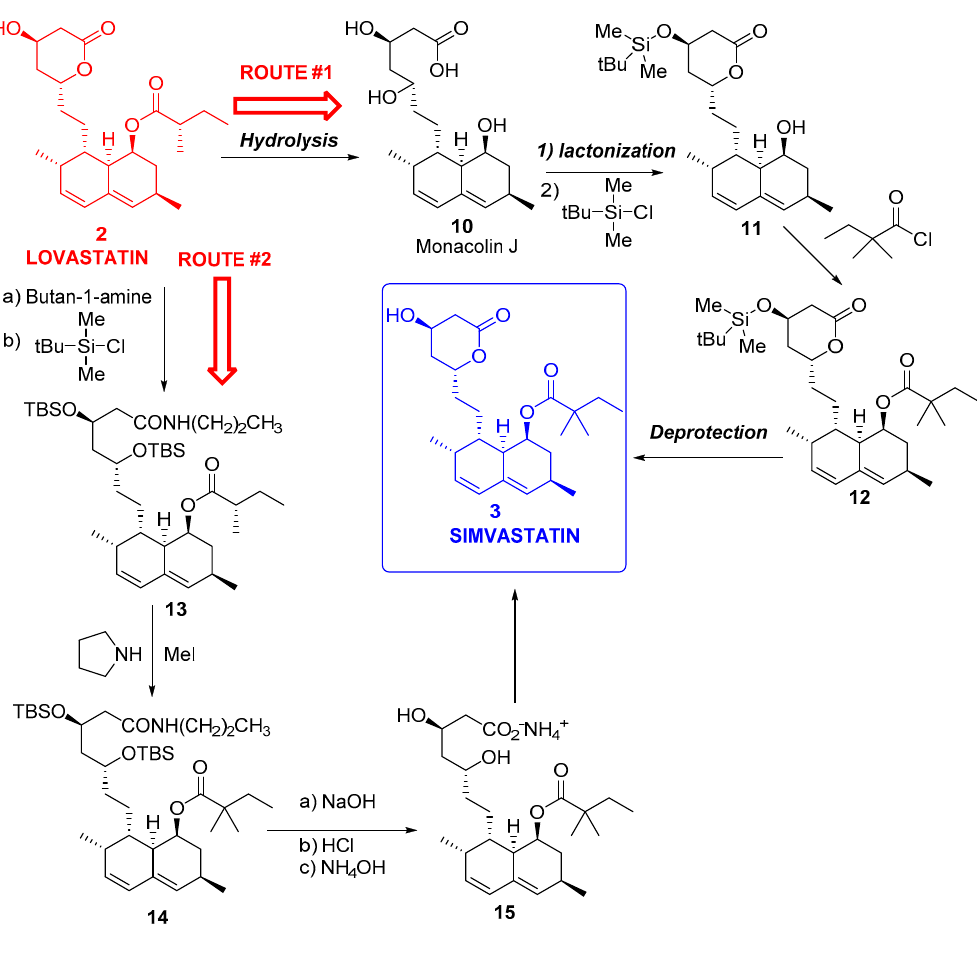
Figure 3. Chemical transformations of lovastatin 2 into simvastatin 3 .